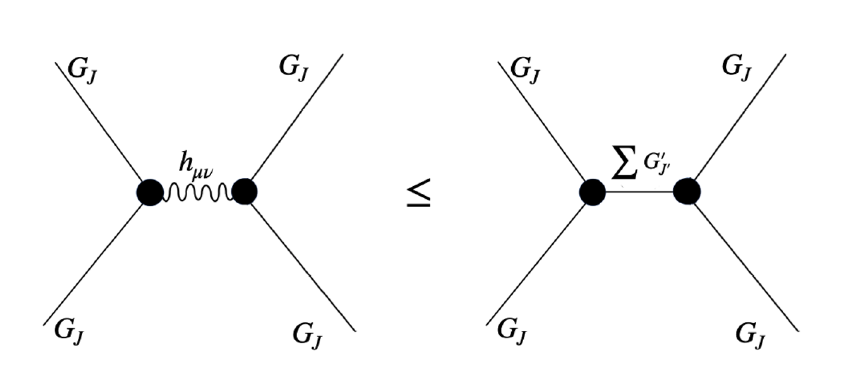
Figure 4 . Causality imposes a constraint on the G J G J → G J G J scattering amplitude for J ≥ 3 in 4d. In the impact parameter space, the gravitational part of the scattering amplitude must be smaller than the non-gravitational part for Λ